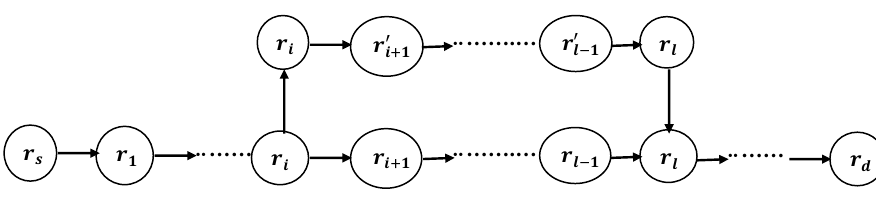
Figure 3. The procedure for constructing a new path X n based on an initial path X c .